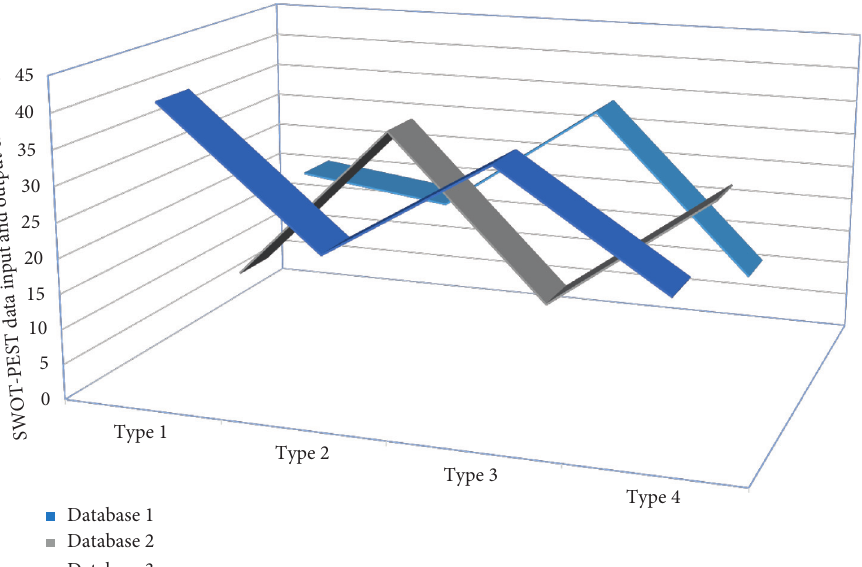
Figure 5: Comparison of SWOT-PEST data input and output